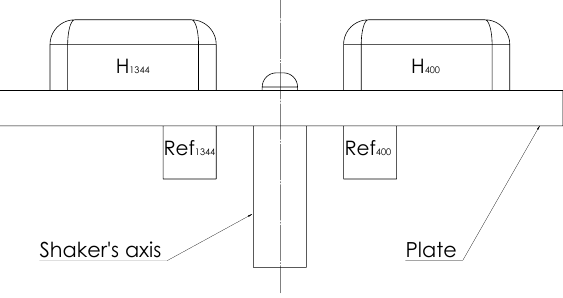
Figure 1. Test bench with the two IMUs (H 1344 , H 400 ) and the two associated references (R 1344 , R 400 ). Sensors are excited by a back and forth motion along the shaker